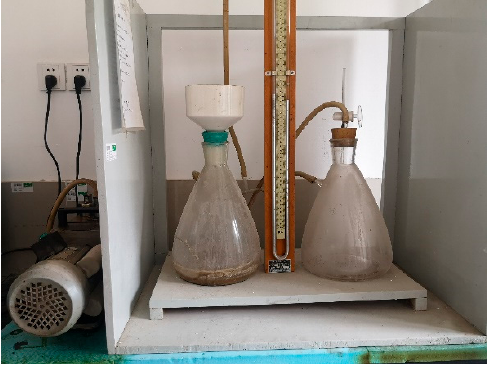
Figure 3. GB/T 28627-2012 test device to determine water retention of mortars. Figure 3. GB / T 28627-2012 test device to determine water retention of